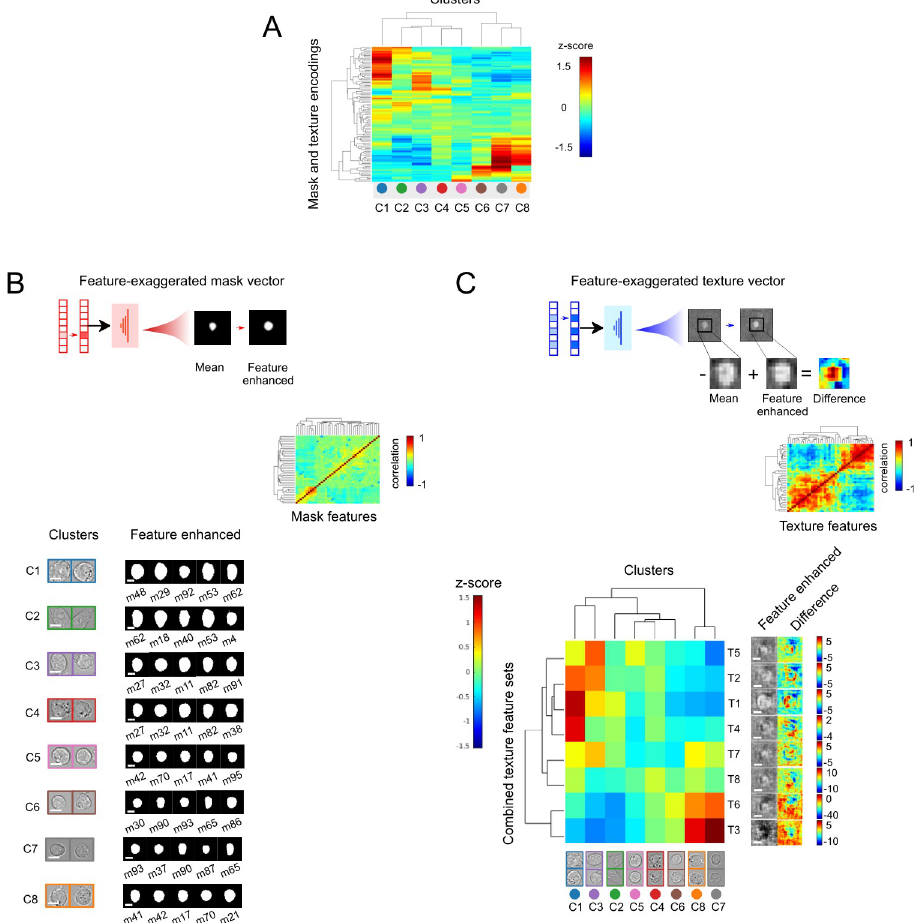
Fig 3. Cell-type specific morphological features can be interpreted by decoding the latent space cell representation. (A) Clustergram of average z-scores for latent shape and texture features for different cell clusters (see Methods section for how z-scores values were calculated). (B) Five mask features with highest z-scores for each morphological cluster are decoded and visualized. Clustergram shows matrix of correlation coefficients for forty mask features having the highest standard variation in the dataset. Scale bar represents 5 μ m. (C) Individual texture features were clustered into eight groups (T1-T8) according to their correlation with each other from the clustergram of texture features. Each group was decoded into brightfield difference images for interpretation (see Methods). Scale bar represents 5 μ